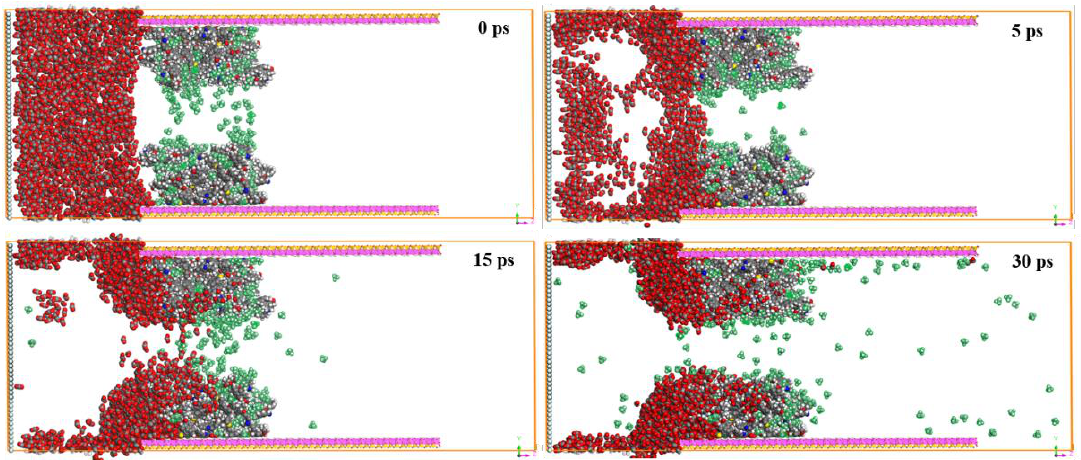
Figure 6. The displacement process of CH 4 by CO 2 with p = 20 MPa and T = 323 K.